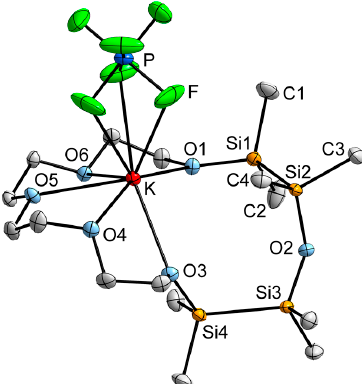
Figure 4. Molecular structure of [K(1,2,4,5-tetrasila[18]crown-6)PF 6 ] ( 4 ) in the crystal. Thermal ellipsoids represent the 50% probability level. Hydrogen atoms are not displayed. Selected bond lengths (pm) and angles (°): K–O1: 283.8(2), K···O2: 505.5(2), K–O3: 279.4(2), K–O4: 274.4(2), K–O5: